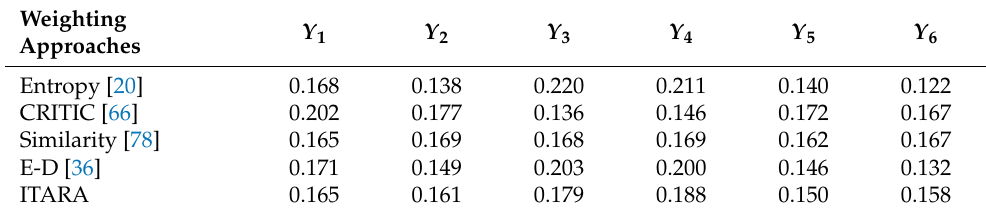
Table 11. The objective weights of attributes calculated by different weighting approaches.